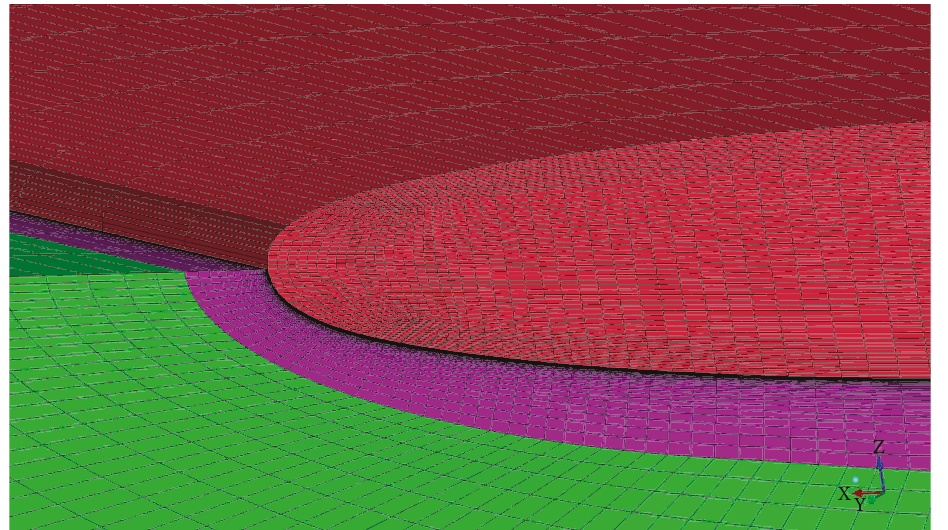
Figure 5: CFD mesh of curved wing (wing tip detail).